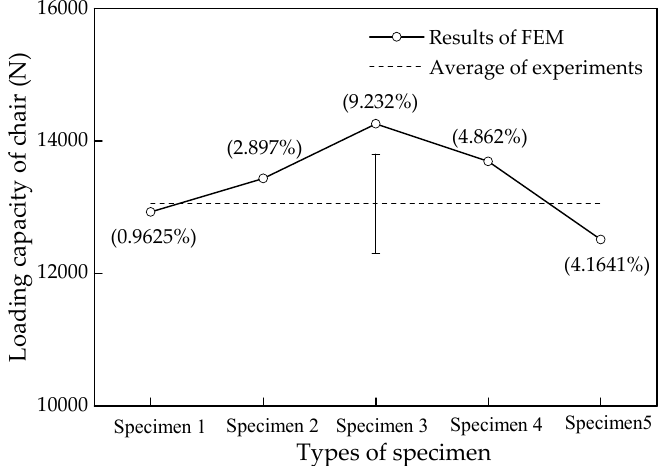
Figure 12. Comparisons of experiments and finite element methods (FEMs) (Errors are shown in parentheses).